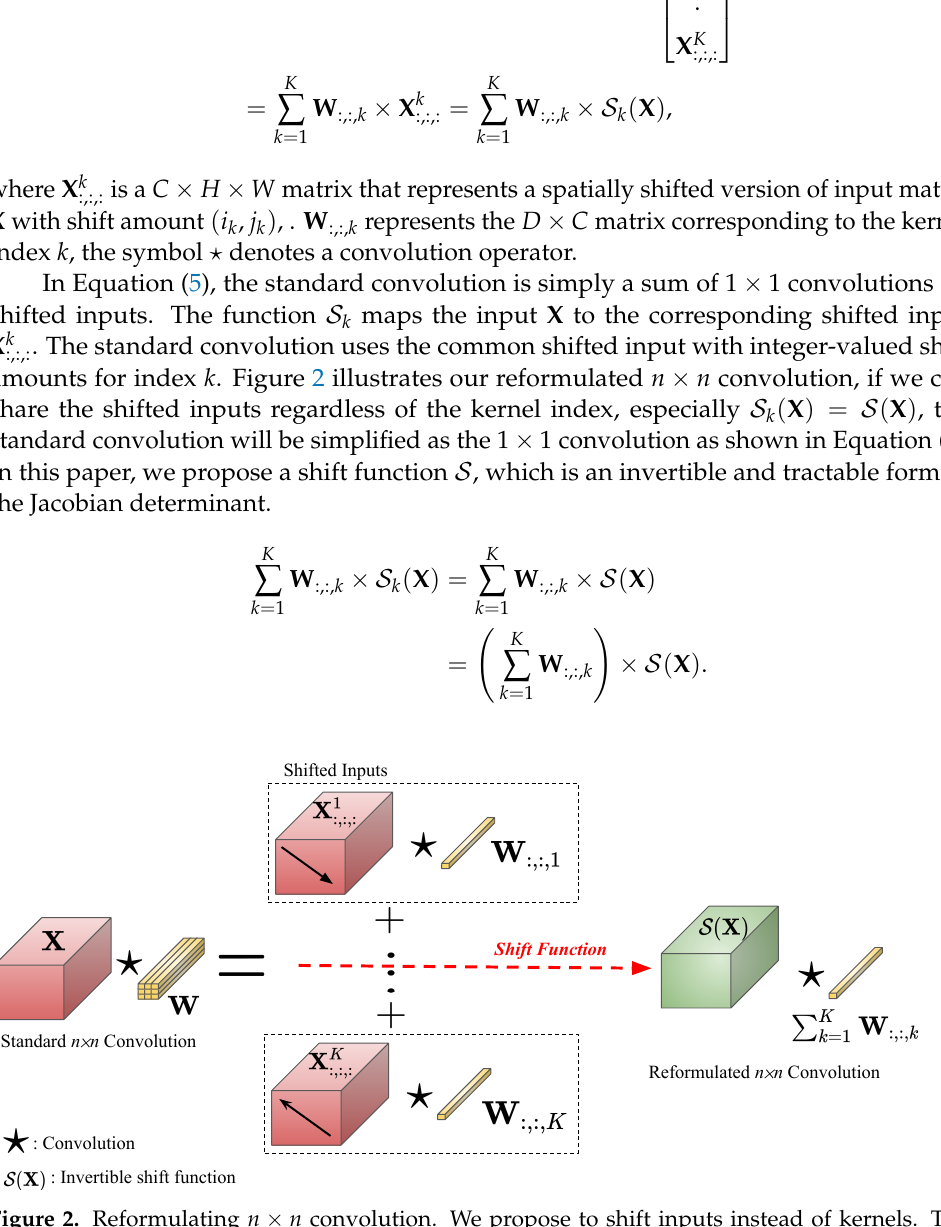
Figure 2. Reformulating n × n convolution. We propose to shift inputs instead of kernels. The proposed invertible n × n convolution will be simplified as a combination of the invertible shift function S and the invertible 1 × 1